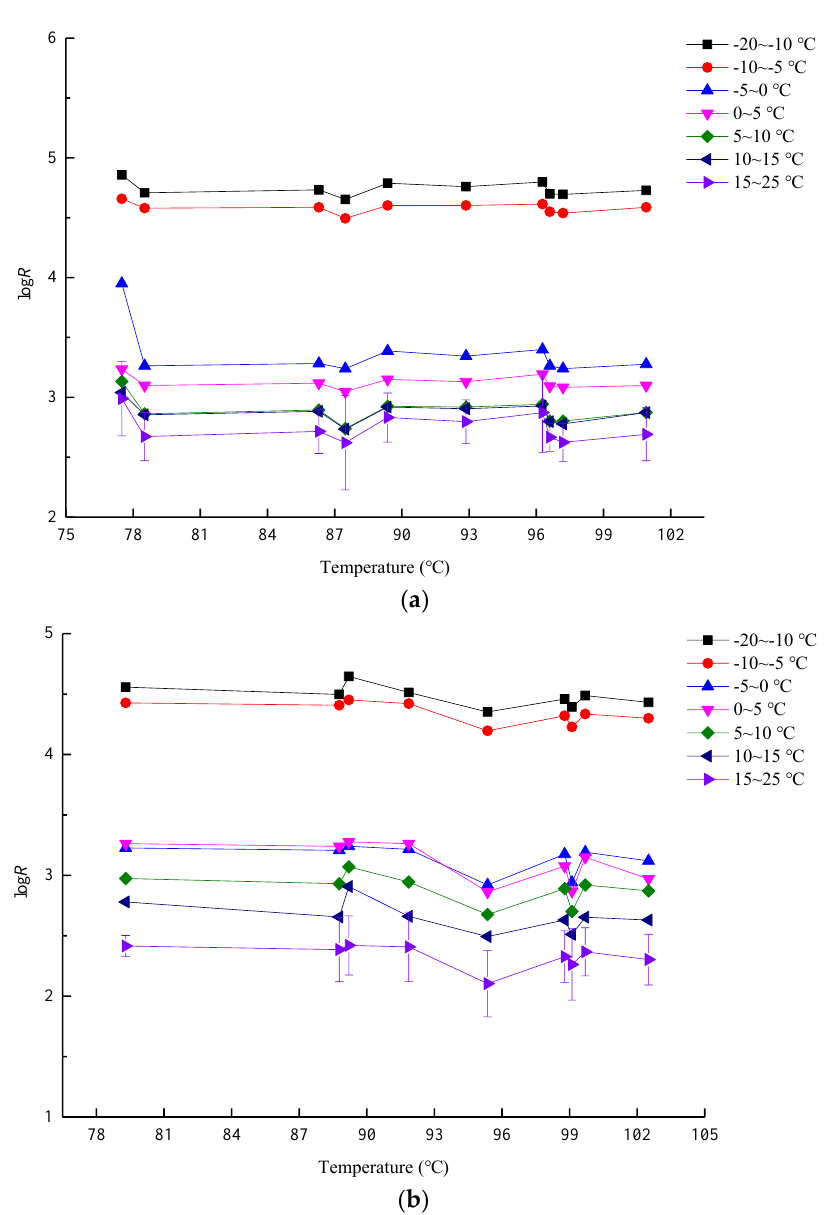
Figure 7. Effect of moisture content on the logarithmic value of mean resistance in the cross-section of living trees ( Larix gmelinii ) under different temperatures. ( a ) Sound trees; ( b ) Decayed trees.